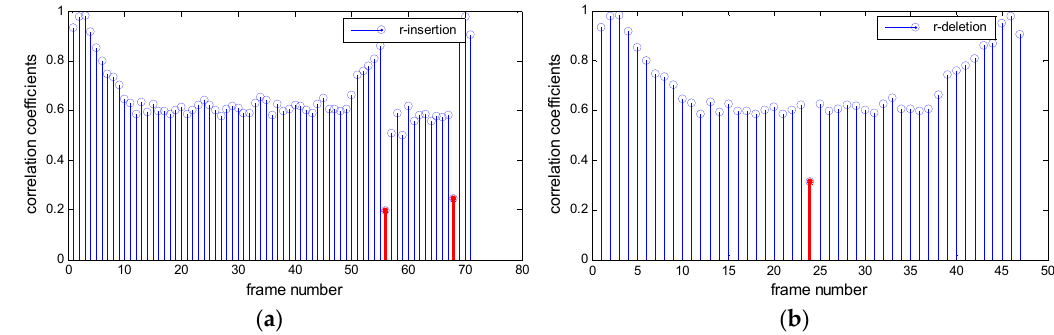
Figure 4. Correlation coefficients of forged video (person15_jogging_forged) ( a ) Frame insertion; ( b ) Frame deletion.